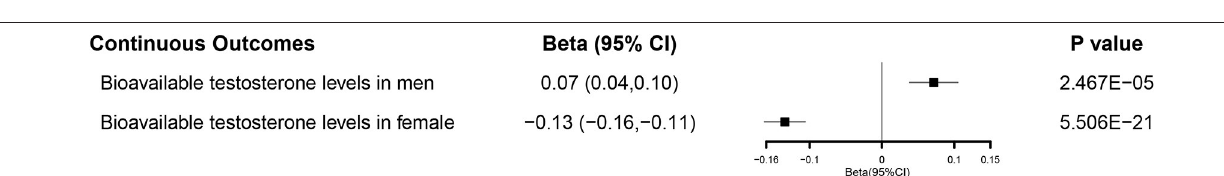
FIGURE 3 | Forest plot of the MR results between EA and two continuous outcomes including bioavailable testosterone levels in male and female. MR, Mendelian randomization; EA, educational attainment; CI, confidence